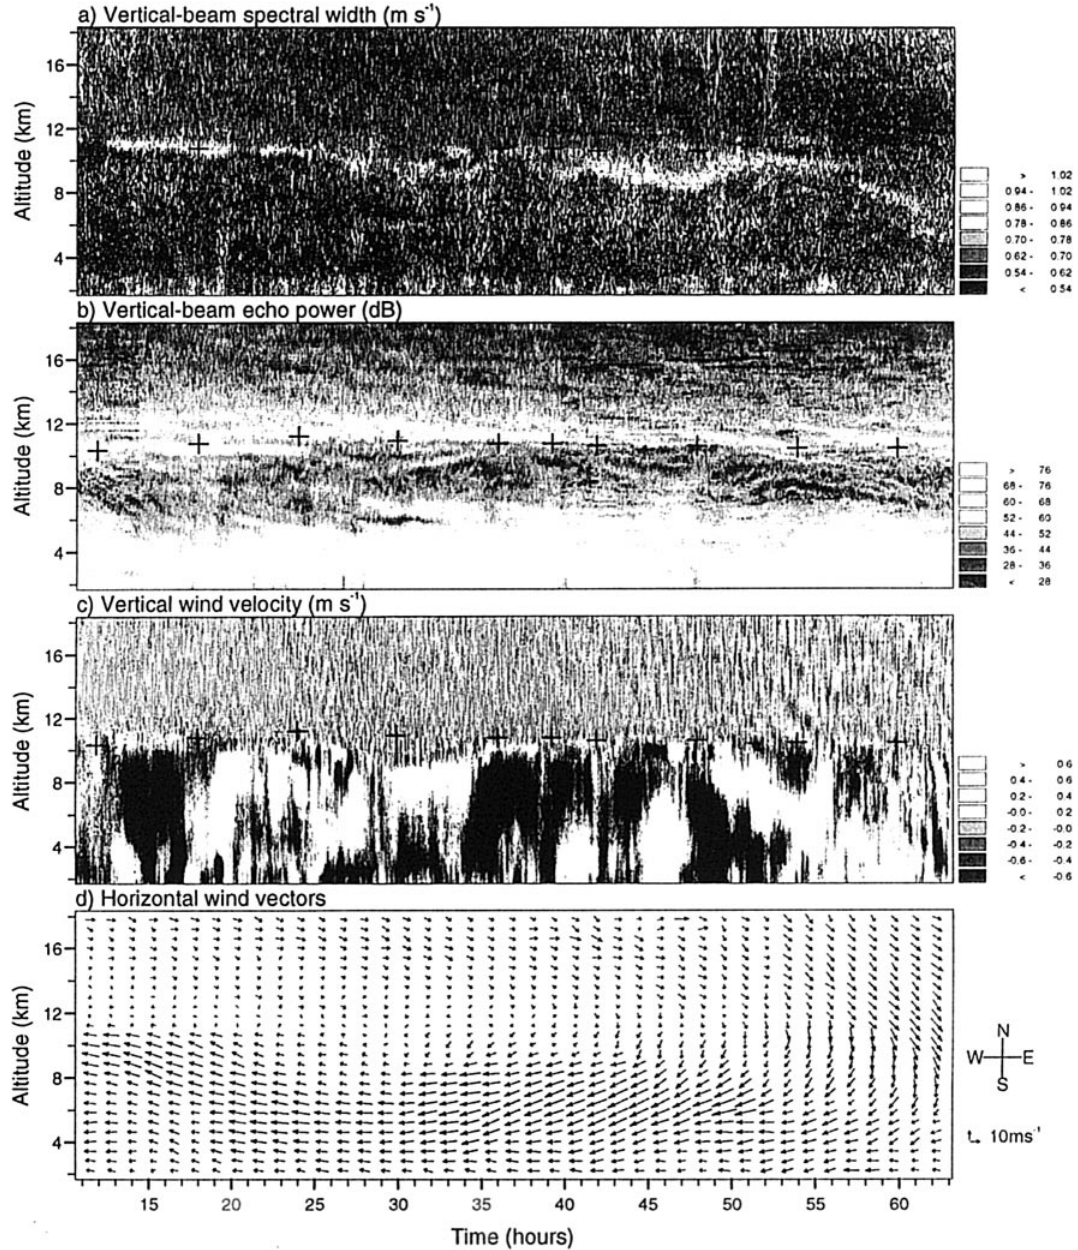
Fig. 11a–d. Height–time plots of ( upper to lower panel ): spectral width, echo power, vertical wind component, and horizontal wind vectors. The data were taken with the Aberystwyth VHF radar from